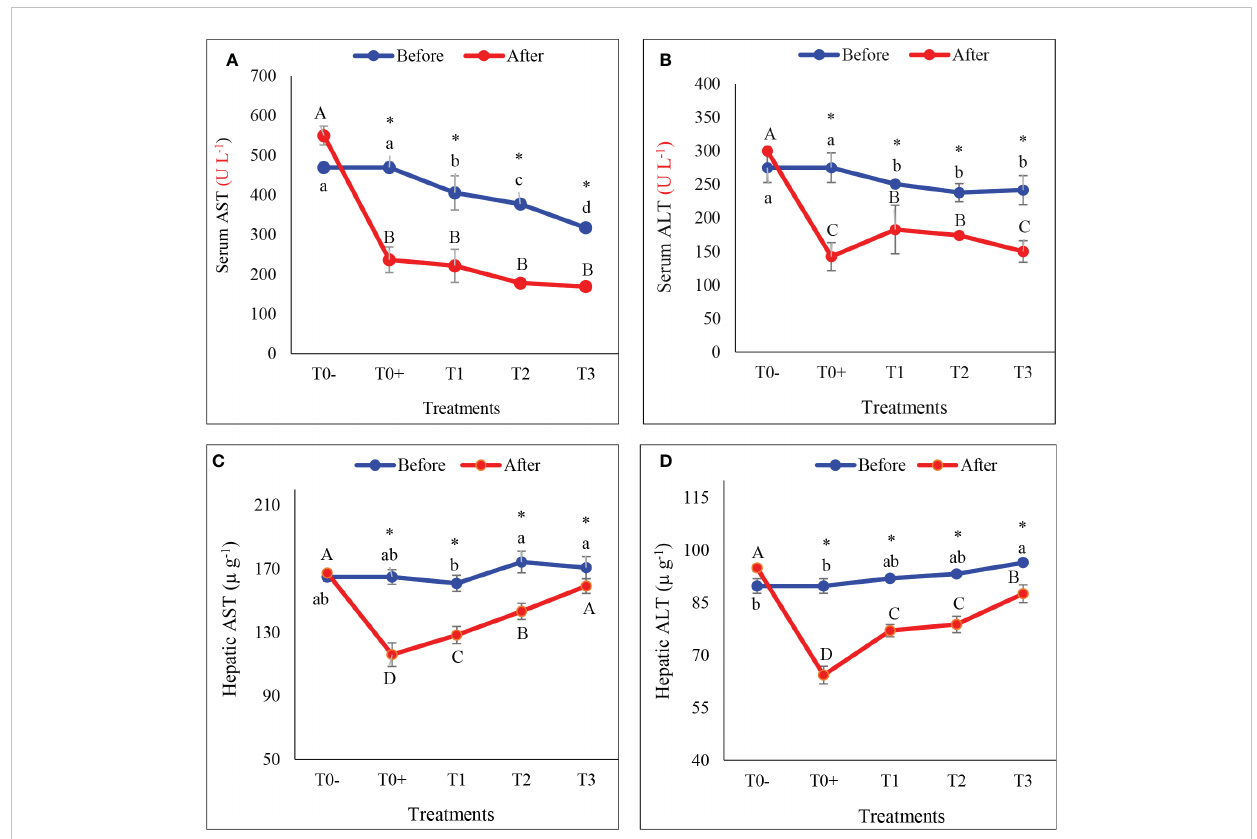
FIGURE 3 Serum and hepatic activities of aspartate transaminase (AST: A, C , respectively) and alanine transaminase (ALT: B, D , respectively) of hybrid red tilapia fed different ratios of corn oil (CO): Aquafat-O ® (AQ-O) and exposed to cold stress. T 0- (the negative treatment), T 0+ (the positive treatment), T 1 (2 CO: 1 AQ-O), T 2 (1 CO: 2 AQ-O), T 3 (3 CO: 0 AQ-O). Vertical bars indicate the standard errors; means with an asterisk indicate a signi fi cant difference between before and after the exposure to cold stress ( p < 0.05). Small and capital letters indicate signi fi cant differences among treatments before and after the exposure to cold stress,